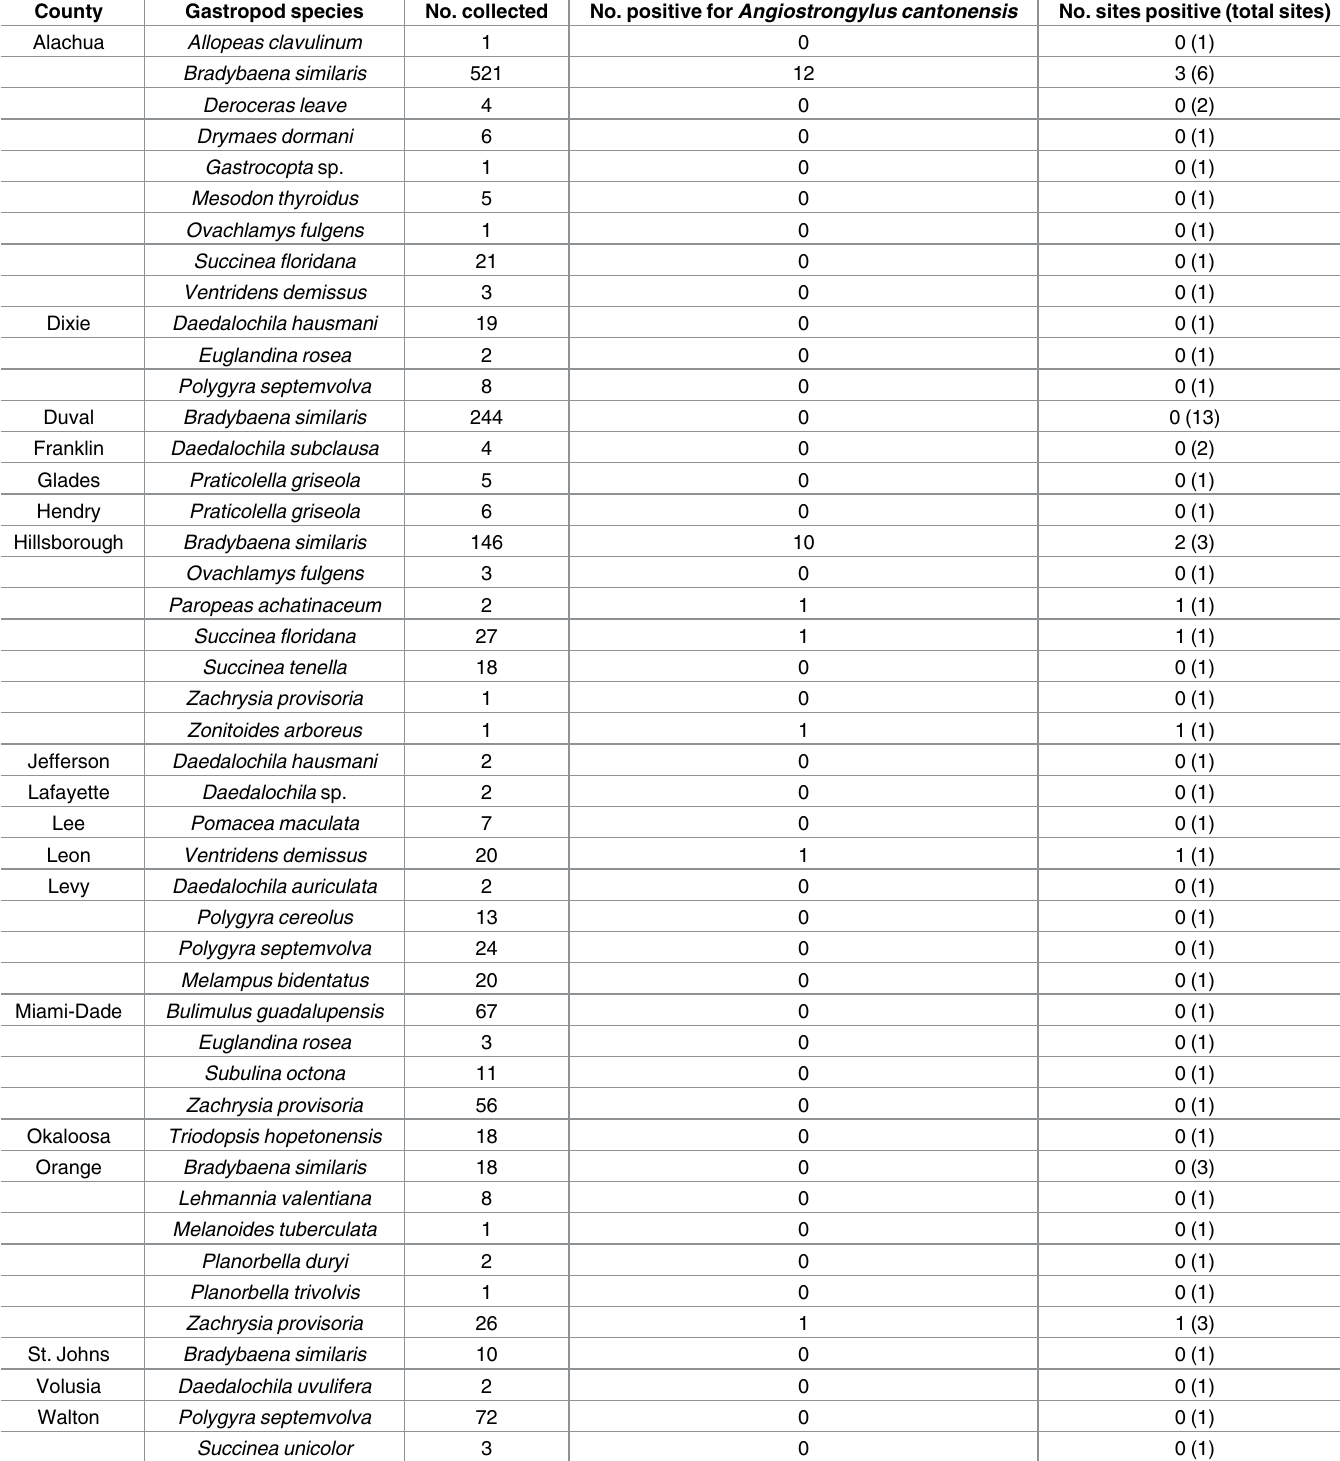
Table 3. Gastropod species collected from multiple sites in 18 counties throughout Florida.